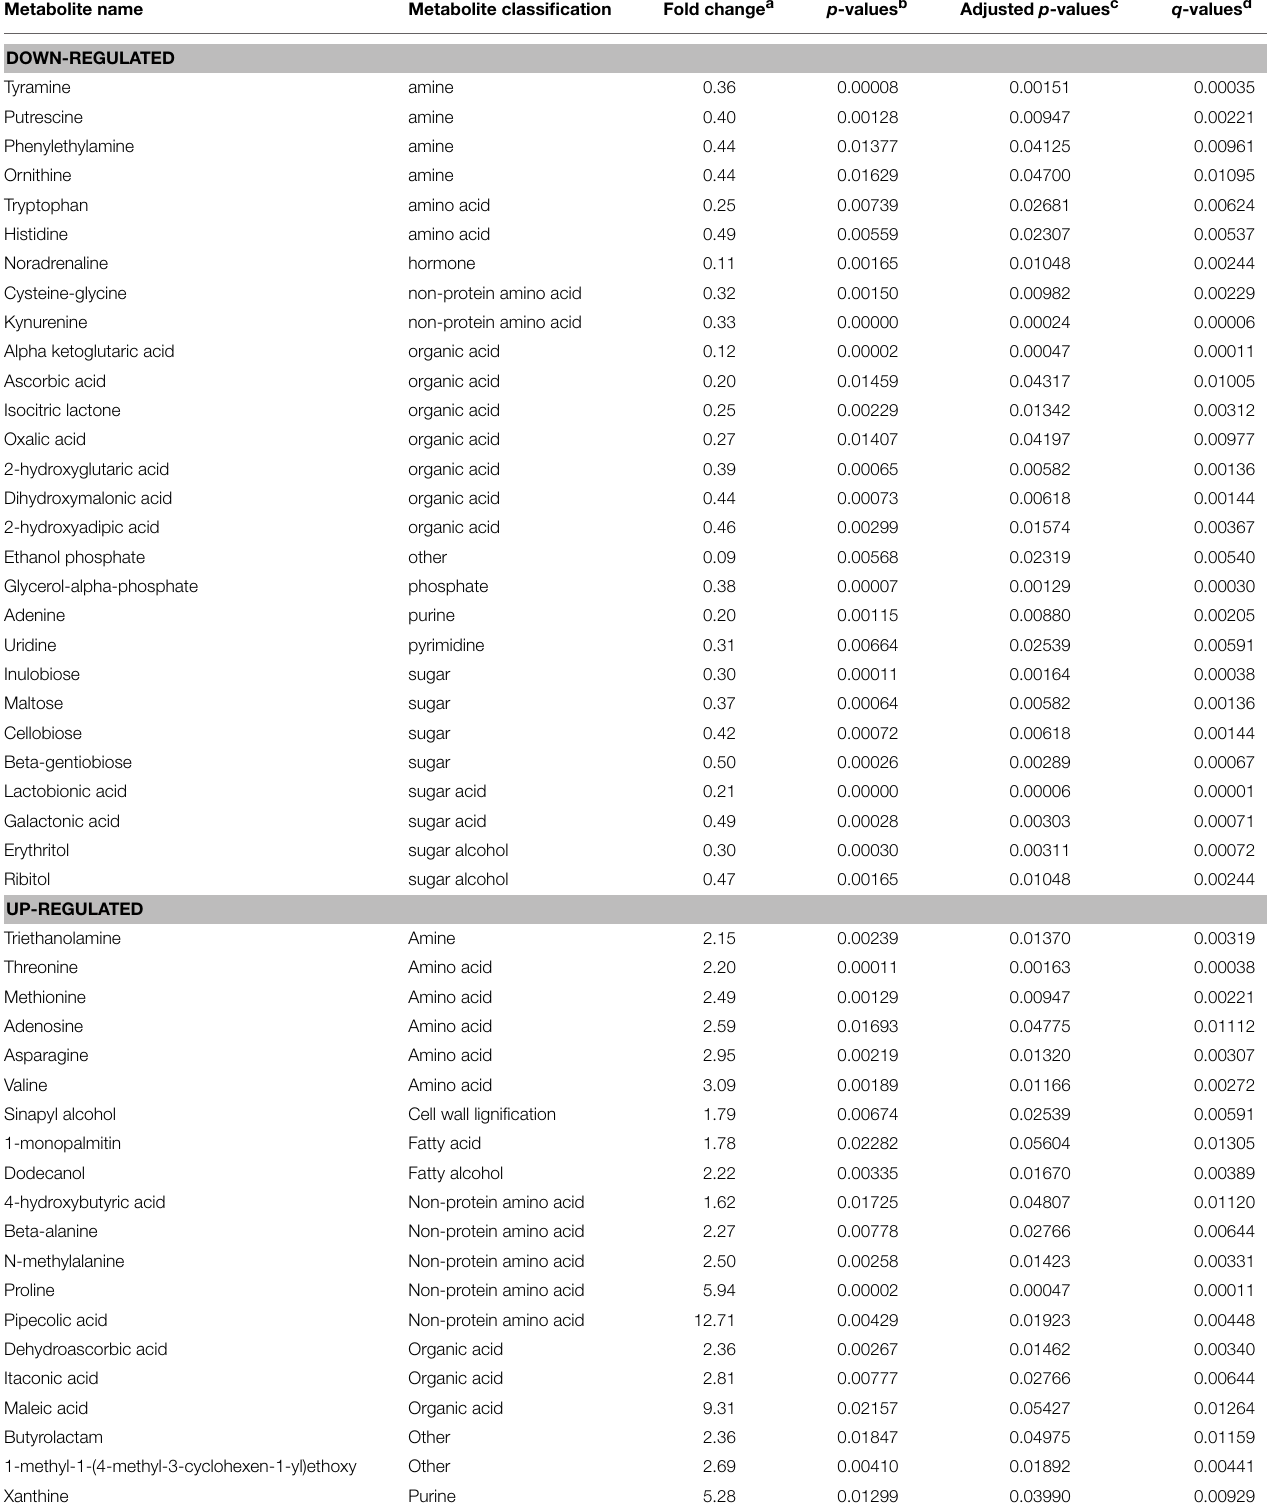
TABLE 1 | Metabolites which were significantly down- or up-regulated by more than 1.5-fold in EBC extracts from salt-treated plants compared to control